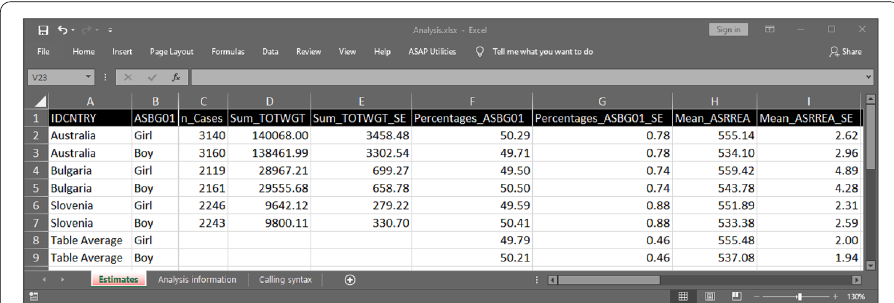
Fig. 2 Partial output from the lsa.pcts.means